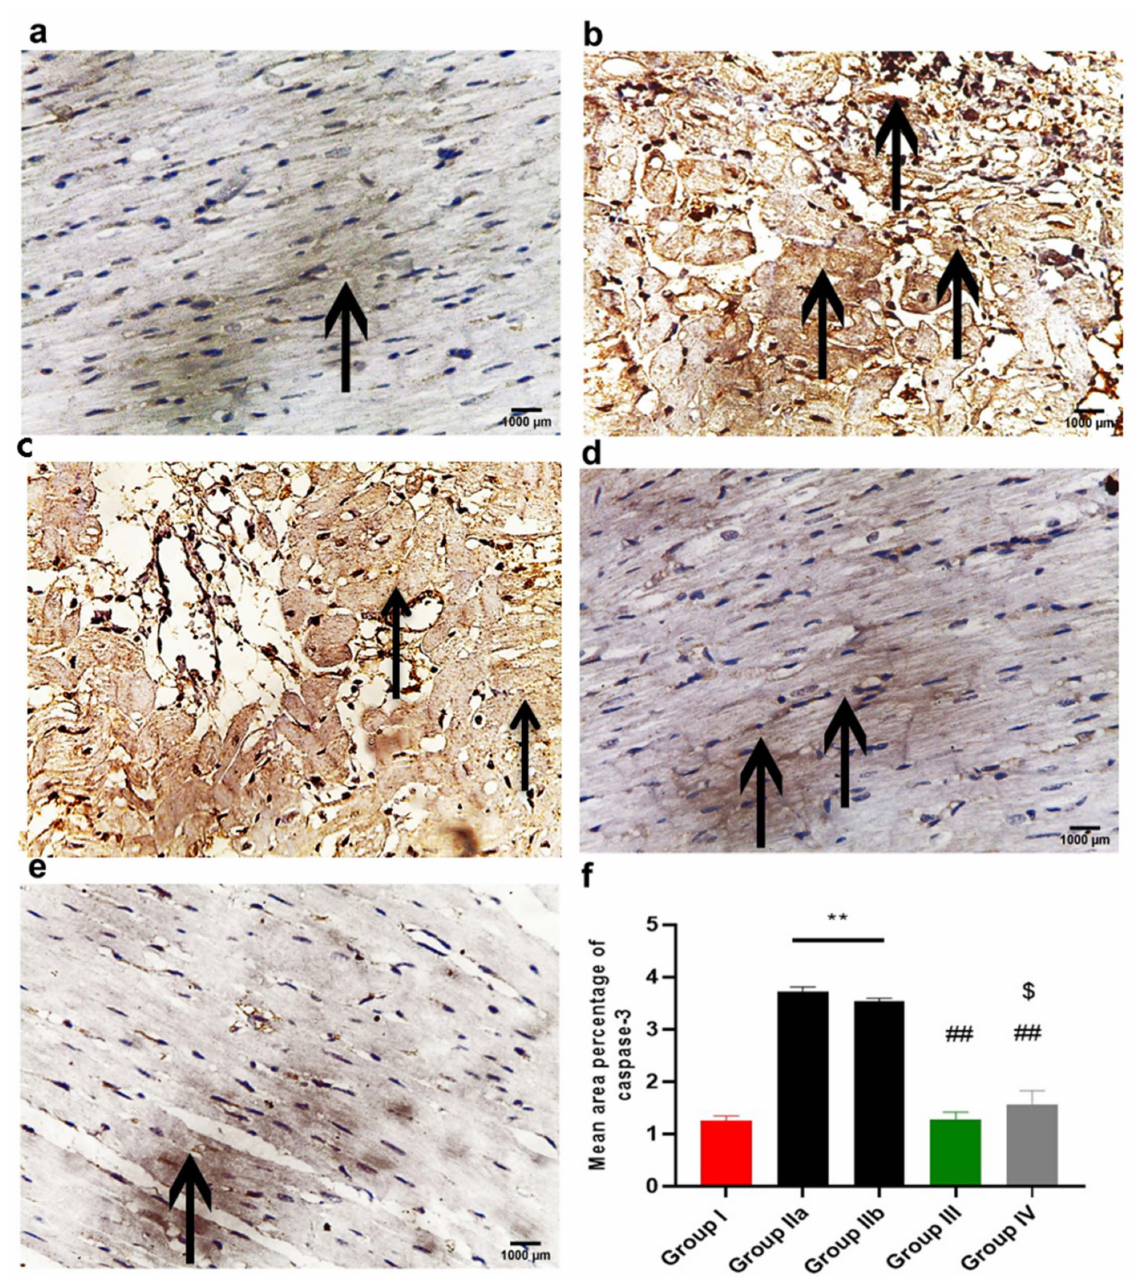
Figure 12. Representative photomicrographs of caspase-3 immuno-stained sections from the left ventricle of the myocardium in the different experimental groups: ( a ) Group I (control group) showed minimal cytoplasmic immuno-expression of caspase-3 in the myocardium; ( b ) Group IIa (DOX/Trz group) showed marked cytoplasmic and nuclear immuno-expression of caspase-3 in the myocardium; ( c ) Group IIb (recovery group) showed moderate cytoplasmic and nuclear immuno- expression of caspase-3 in the myocardium; ( d ) Group III (prophylactic group) showed minimal cytoplasmic immuno-expression of caspase-3 in the myocardium; ( e ) Group IV (curative group) showed low cytoplasmic immuno-expression of caspase-3 in the myocardium; and ( f ) Histogram representing the mean area percentage of caspase-3 immuno-reaction in all experimental groups. **, significant compared to Group I at p < 0.01; ##, significant compared to Group II at p < 0.01; $, significant compared to Group III at p < 0.05; n =